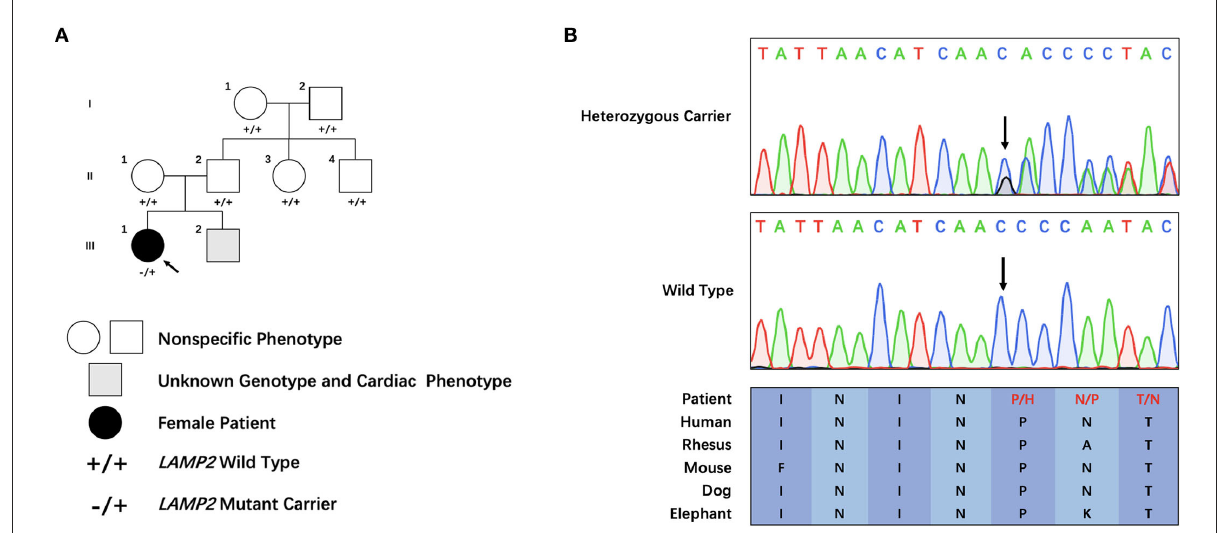
FIGURE2 Clinical and genetic characteristics of the pedigree. (A) Family tree of the cardiac-only Danon disease pedigree. (B) Sanger sequencing of the family. Colored blocks indicate evolutionary conservation of the cluster across multiple